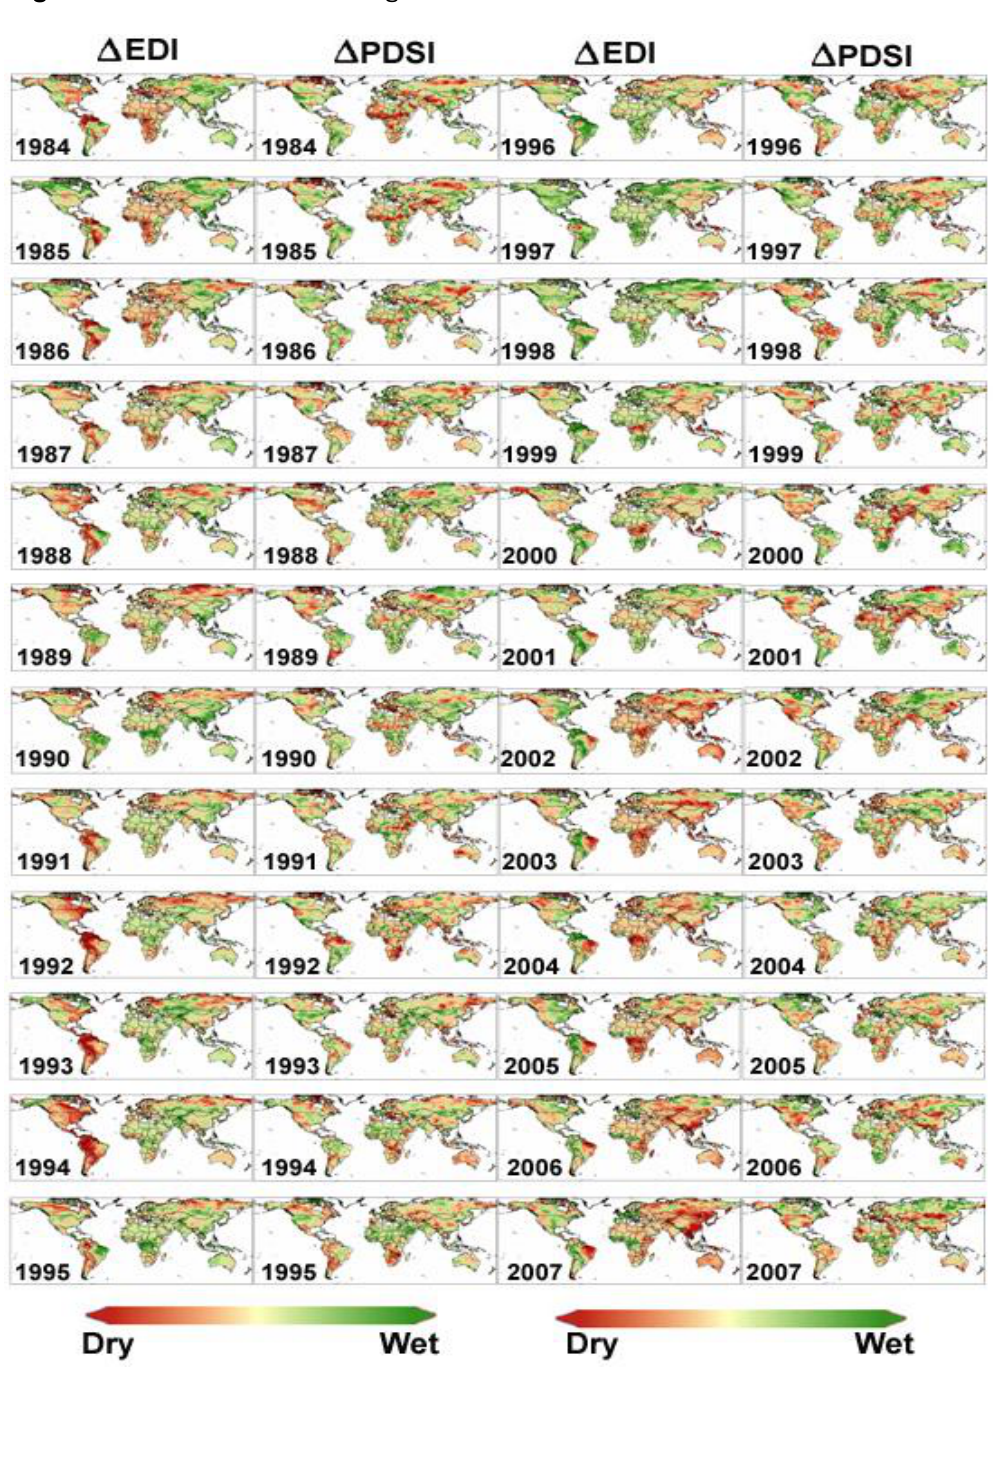
Figure 9. Annual anomalies in global land surface EDI and PDSI for